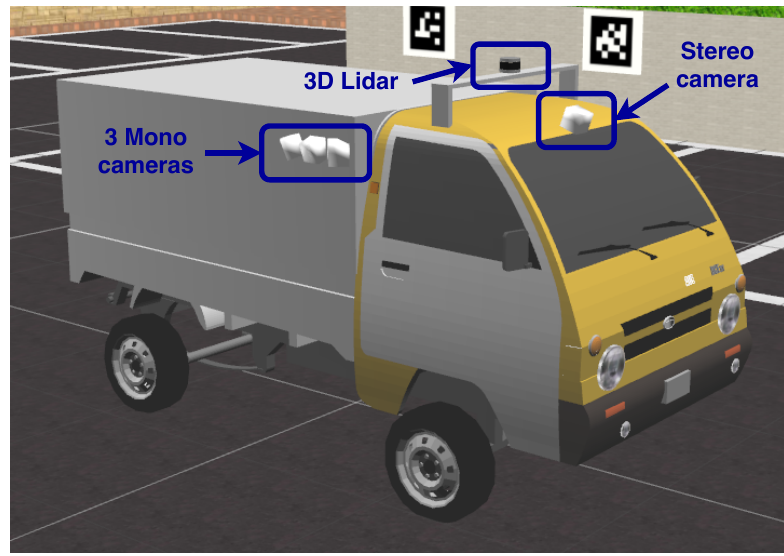
Figure 2. The test vehicle we designed in ROS and Gazebo showing sensor configuration.